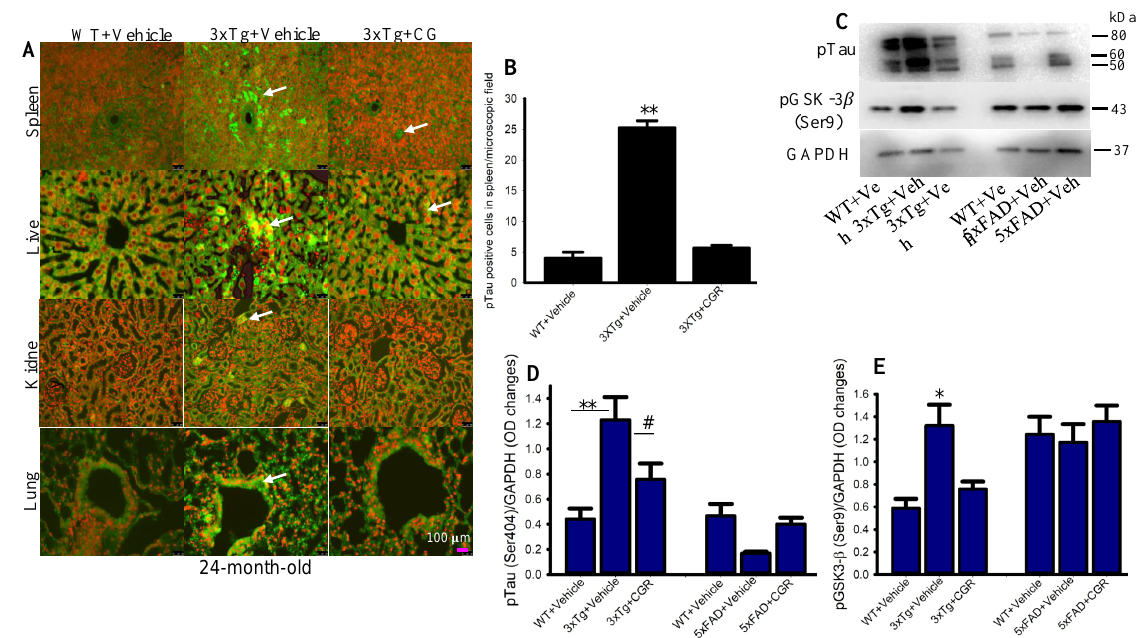
Figure 11. Phosphorylated tau immunoreactivity (pTau-IR) in peripheral organs was reduced by CGR treatment in 3xTg mice. Paraformaldehyde fixed, paraffin-embedded tissue sections at 5 µ m from the WT, 3xTg and 3xTg+CGR mice were immunolabeled with pTau antibodies. The images were taken by a fluorescent microscope using 40 × objectives (total magnification = 400 × ). ( A ) Representative photomicrographs of the spleen, liver, kidney and lungs from 24-month-old 3xTg mice after treatment with CGR. Note that the number of pTau-IR (arrows) were significantly increased in the spleen ( B ) and all other tissues (data not shown), whereas CGR treatment prevented the increase in the number of pTau-IR cells. ( C – E ) Western blot was performed from spleen tissue and labeled with pTau, pGSK-3 β and GAPDH as a loading control. Note that pTau ( C , D ) and pGSK-3 β ( C , E ) levels were significantly increased in 3xTg mice (not in 5xFAD mice) and CGR treatment significantly reduced those levels. Scale bar =100 µ m and is applicable to all other images. * p < 0.05, ** p < 0.01 in comparison to WT and 3xTG+CGR; # p < 0.05 in comparison to